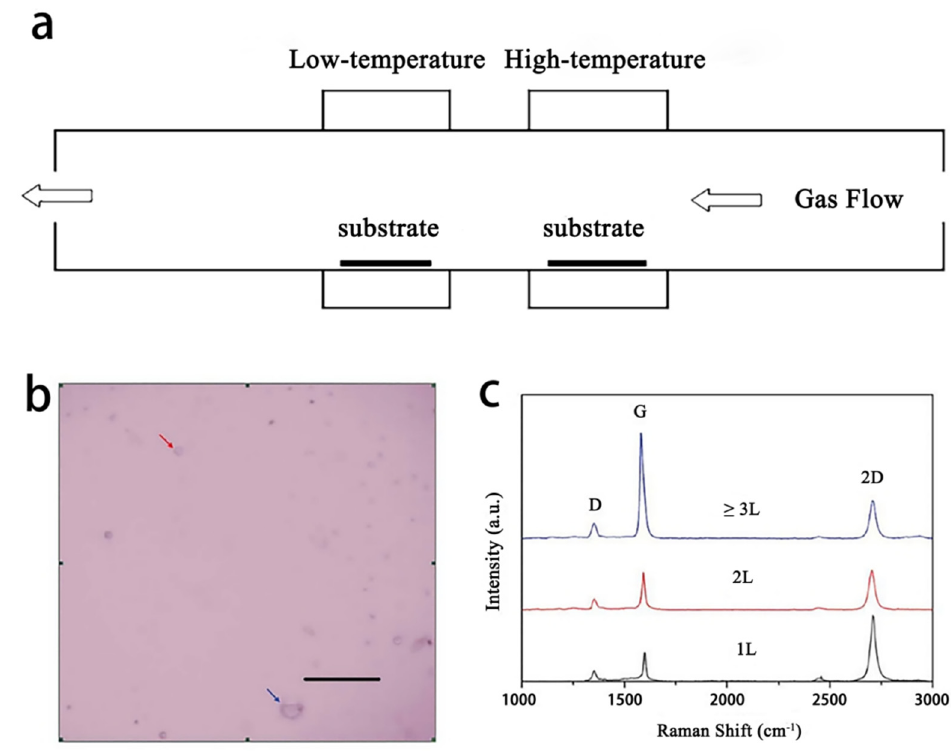
Figure 3. Graphene growth in a tube furnace. ( a ) Schematic diagram of graphene on SiO 2 substrate, assembled with two temperature zones; ( b ) Light microscope image of the sample after growth in the low temperature zone; ( c ) Raman spectra of three regions corresponding to the blue and red arrow labeled areas as well as the background, showing the presence of single, double, and multilayer graphene. Scale bar: 10 μ m [34].